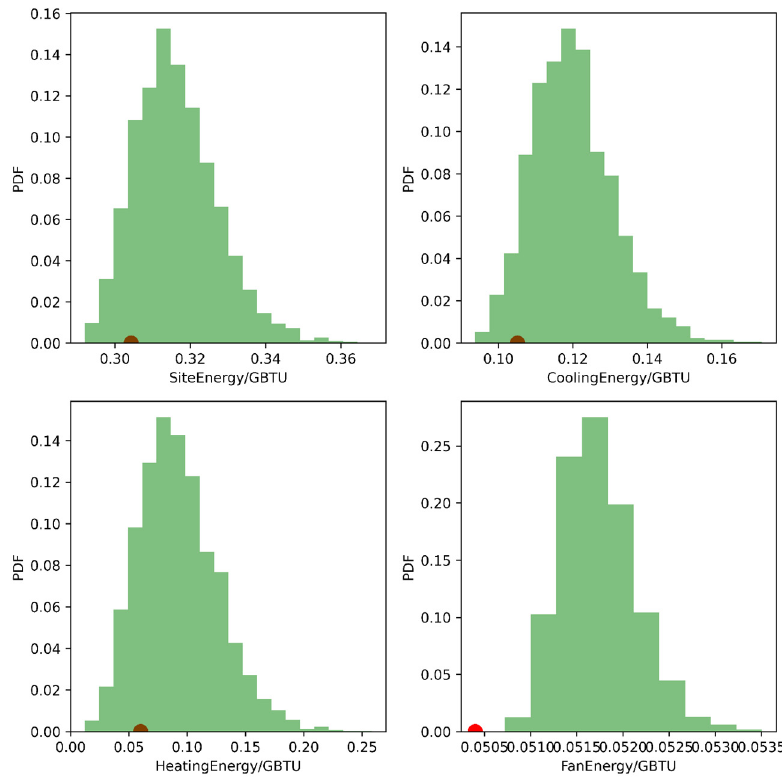
Figure 11. Energy distributions and baseline energy items.